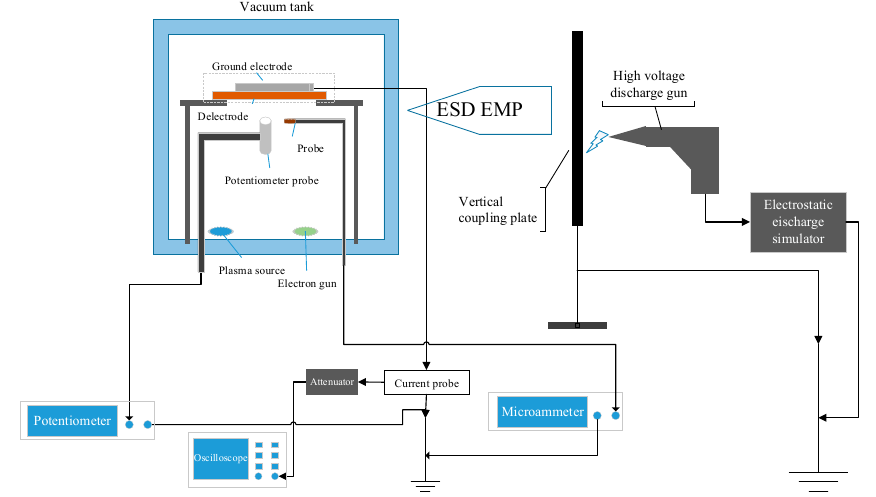
Figure 2. Connection diagram of ESD induced by ESD field pulse on dielectric materials.